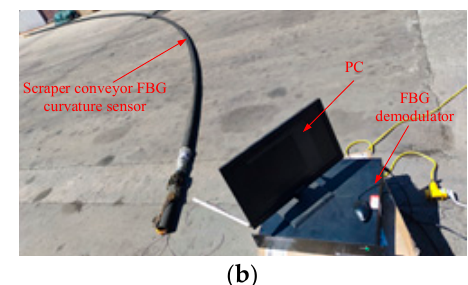
Scraper conveyor FBG curvature sensor